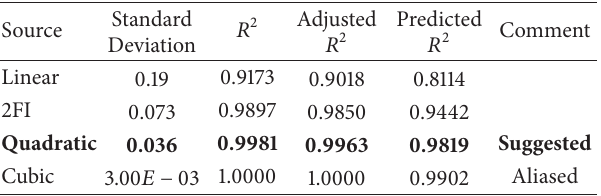
Table 3: Regression statistics for adsorption capacity (model for response 𝑌 2